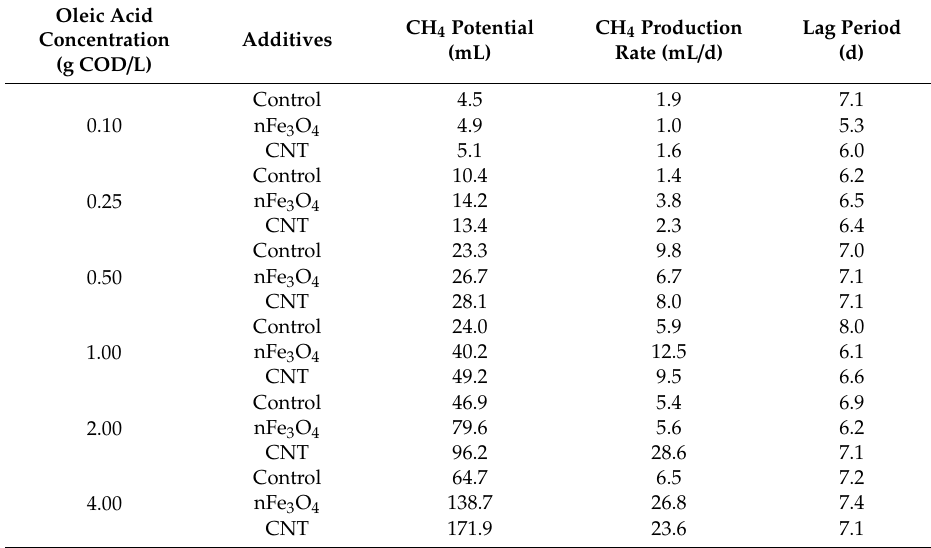
Table 1. Batch anaerobic digestion performances at various OA concentrations and kinetic results obtained by using the modified Gompertz equation (r 2 >